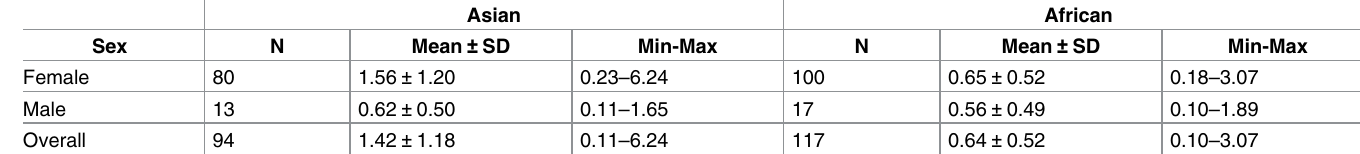
Table 4. Mean ± SD and range of insulin concentrations (mg/ml) in male and female Asian and African elephants.